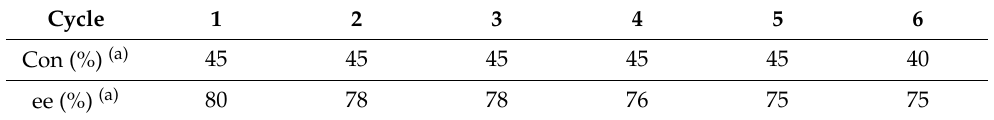
Table 2. Heterogeneous catalyst recovery